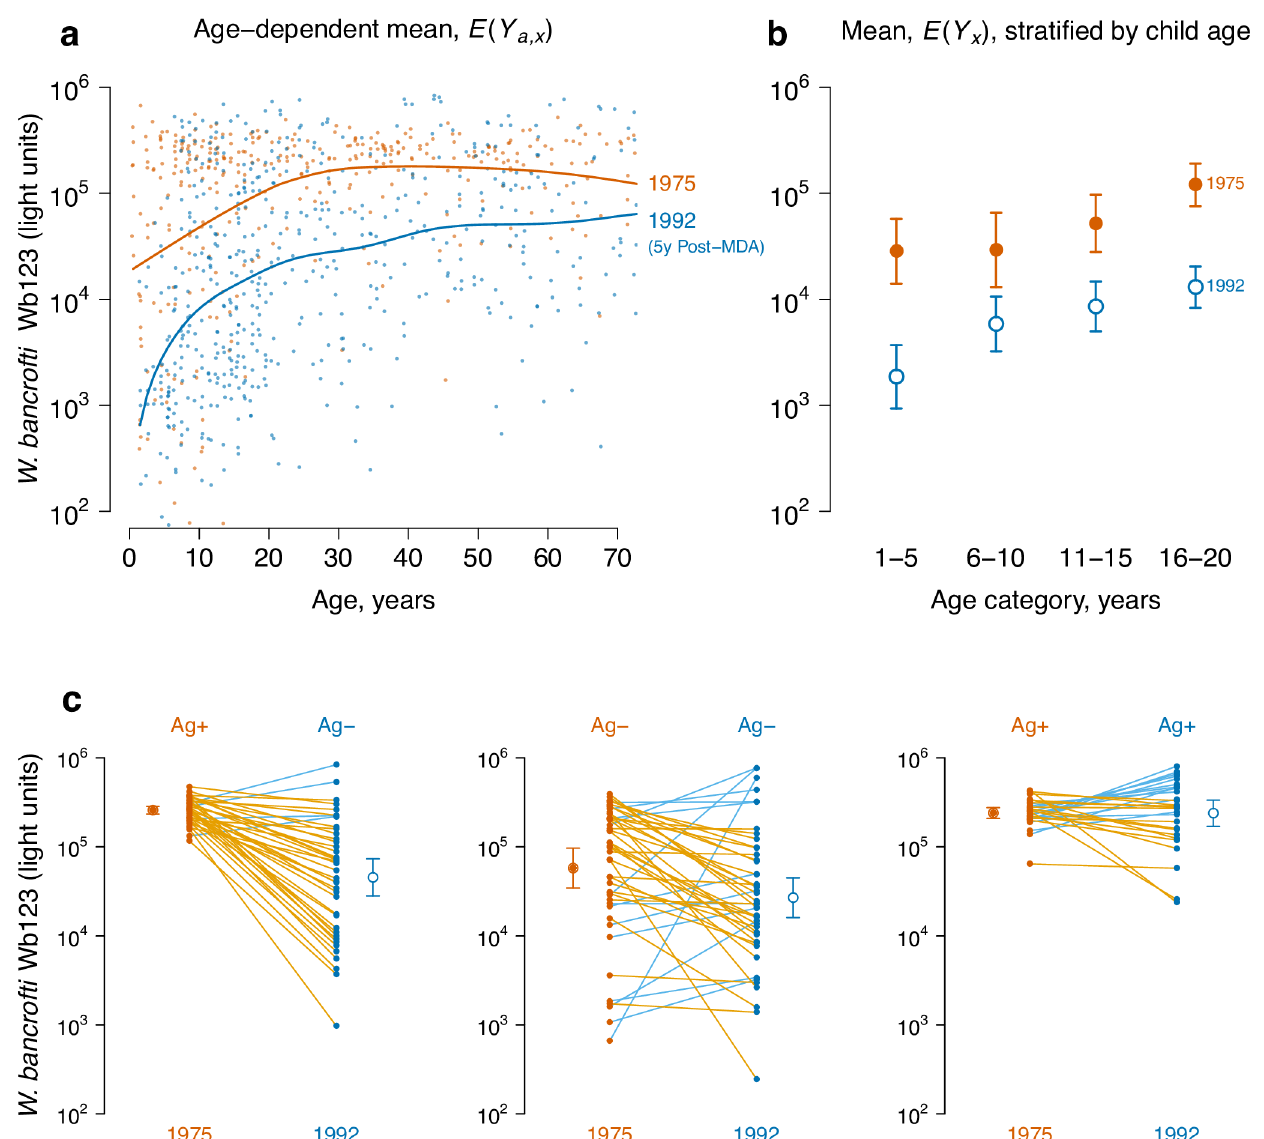
Fig 1. A shift in the Wuchereria bancrofti Wb123 age-antibody curve measuresa reduction in transmission due to mass drug administration (MDA) on Mauke Island. IgG antibodyresponse to the Wb123 antigenfor W . bancrofti measuredin blood specimens from residents in 1975 (N = 362) before MDA and again in 1992 (N = 553), five years followinga single,island-wide MDA with diethylcarbamazine. a , Mean antibodylevels E ( Y a , x ) by age ( a ) and survey year ( x ); individualantibody responses (points) are shown along with summary curves. b , Age-adjustedgeometric mean antibody response, E ( Y x ), and 95% confidenceintervalsbefore (1975) and five years after (1992) MDA, stratified by 5 year age category (all differencessignificantat P (cid:20) 0.0001after Bonferroni correction). c , Wb123 antibody responsein 1975 and 1992 stratified by the presence of circulatingfilarial antigens(Ag) at each measurement in the subsampleof 112 individuals who were measuredat both time points (two individualsnot shown were Ag- in 1975 and Ag+ in 1992), alongwith age-adjusted geometricmeans, E ( Y x ), and 95% confidenceintervals. Differences betweenmeans are significant(Bonferronicorrected P (cid:20) 0.01) except for the Ag+/Ag+ group. Individual trajectories are colored by the higherof the two measurements: decreases are orange, increasesare blue. The source data used to generatethis figure are here: https://osf.io/8tqu4 (mauke), and the scripts used to generate the figure are here: https://osf.io/ek3sx (mauke).